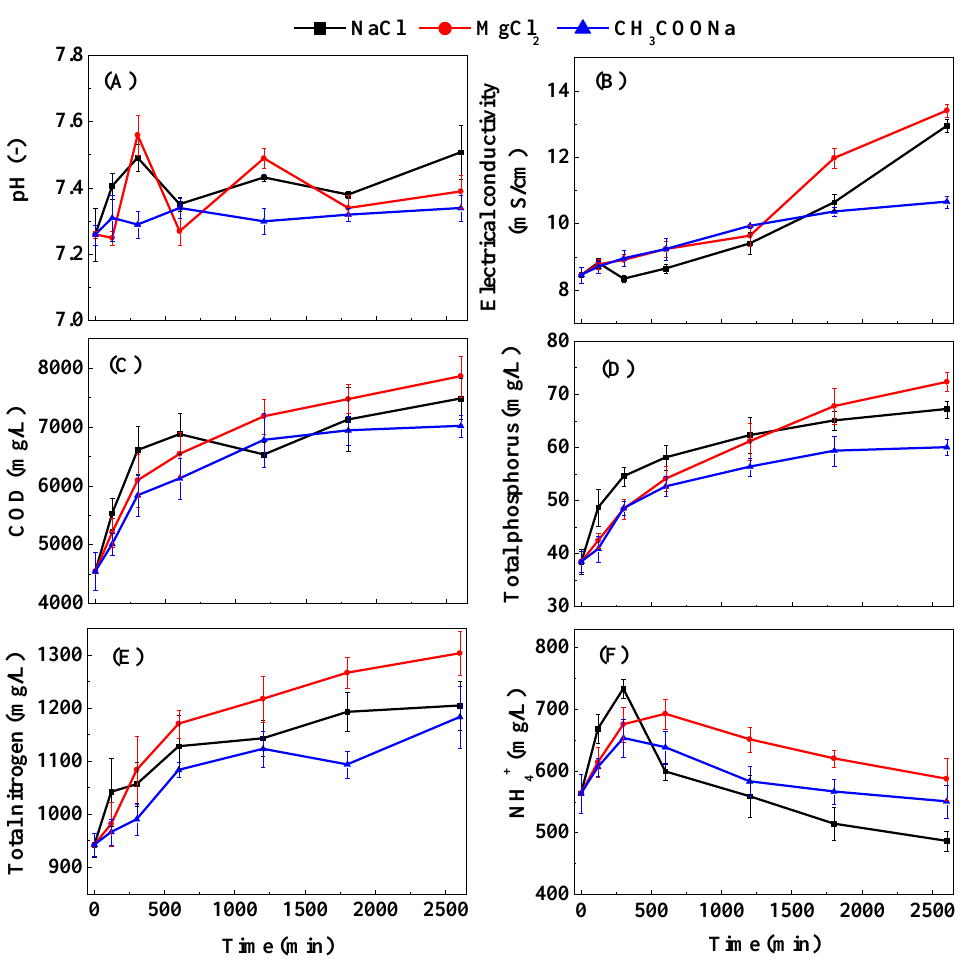
Figure 3. Change in the basic characteristics: pH ( A ), electrical conductivity ( B ), COD ( C ), total phosphorus ( D ), total nitrogen ( E ), NH 4+ ( F ) of each treatment. Error bar represents standard deviation from duplicate experiments.